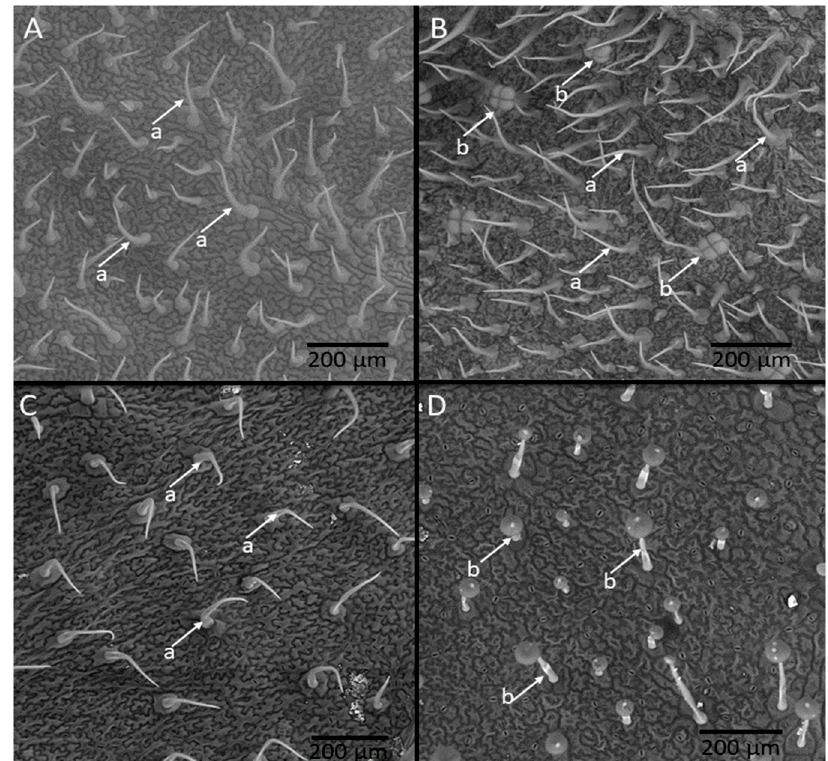
Figure 3. Non ‐ glandular (a) and glandular (b) trichomes present on the surface of RVTA pl#17 ‐ Low Figure 3. Non-glandular (a) and glandular (b) trichomes present on the surface of RVTA pl#17-Low ( A ), ( A ), RVTA pl#306 ‐ High ( B ), S. lycopersicum ‘Redenção’ ( C ), and S. pennellii ( D ). RVTA pl#306-High ( B ), S. lycopersicum ‘Redenç ã o’ ( C ), and S. pennellii ( D